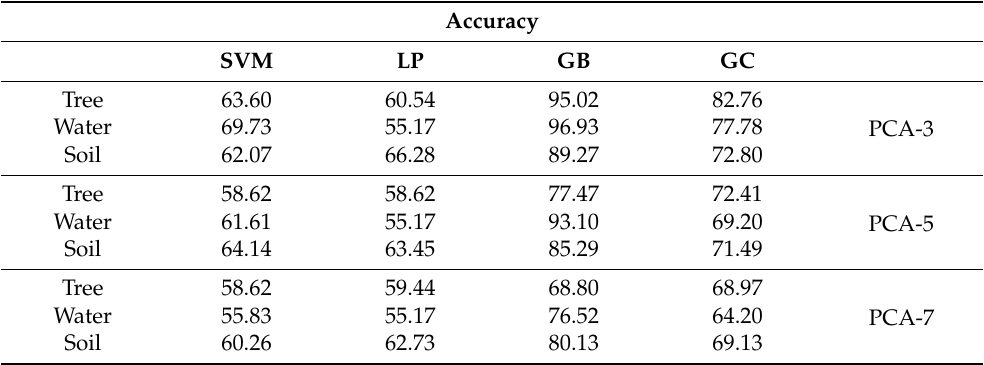
Figure 16. ( a ) Tree class reconstructed image with label 0 (blue) for pixels Not Belonging to tree class, label 1(green) for Strong Belonging pixels to tree class, and label 2 (brown) for pixels Weakly Belonging to tree class. ( b ) Water class reconstructed image with label 3 (blue) for pixels Not Be- longing to water class, label 4 (green) for Strong Belonging to water class, and label 5 (brown) for pixels Weakly Belonging to water class, ( c ) Soil class reconstructed image with label 6 (blue) for pixels Not Belonging to soil class, label 7 (green) for pixels Strongly Belonging to soil class, and label 8 (brown) for pixels Weakly Belonging to Soil class, ( d ) Original groundtruth for tree class, ( e ) Orig- inal groundtruth for water class, and ( f ) Original groundtruth image for soil class. Tables 7 and 8 show the accuracy and F1 score obtained from 10-fold cross validation for three clusters with 3, 5, and 7 PCA bands, using the three scaling methods of stand- ardization normalization, min–max scaling, and maximum scaling for the Jasper HSI. The structural similarity index measure (SSIM) between the original and reconstructed image pixels is 1.0 for the tree, water, and soil classes. Best results are obtained with three PCA